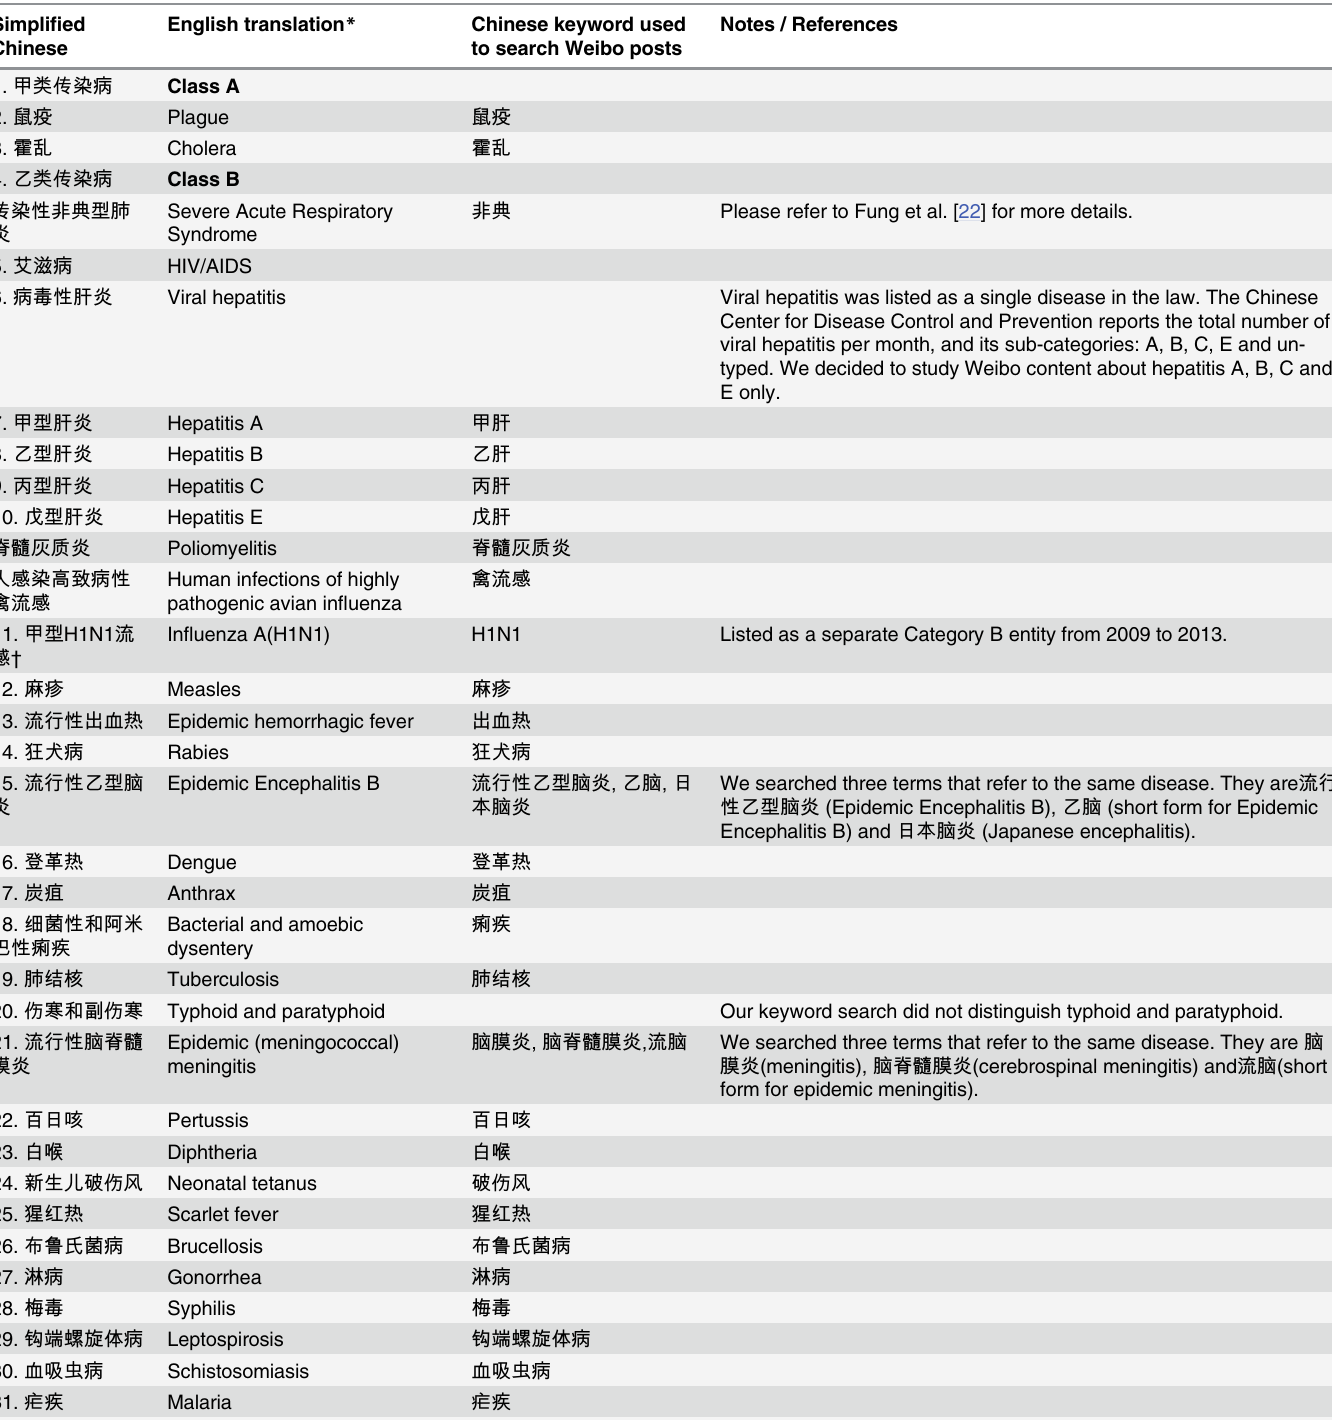
Table 1. List of infectious diseases notifiable in mainland China according to the Law of the People ’ s Republic of China on the Prevention and Treatment of Infectious Diseases (as of 2012), and the corresponding keywords used to search Weibo posts. Simpli fi ed English translation Chinese